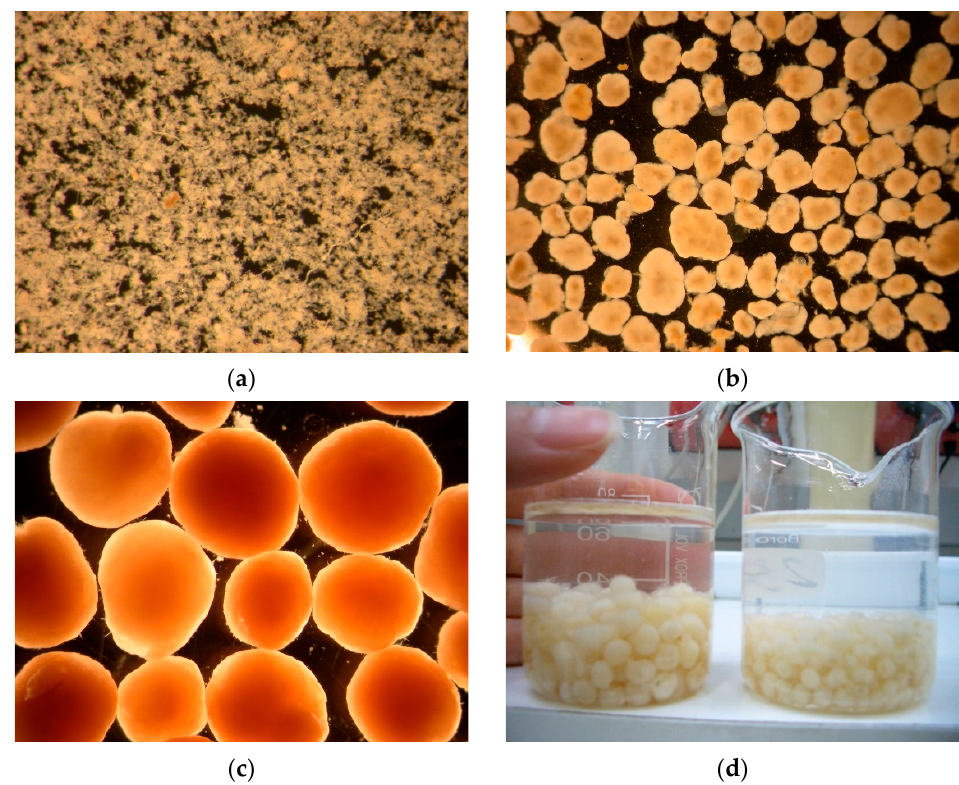
Figure 1. Images for development of granules with time from SBR1 (synthetic wastewater). ( a ) Day 0 (inoculum, floc sludge); ( b ) day 60; ( c ) day 150; ( d ) day 230. Scale bar = 2 mm.